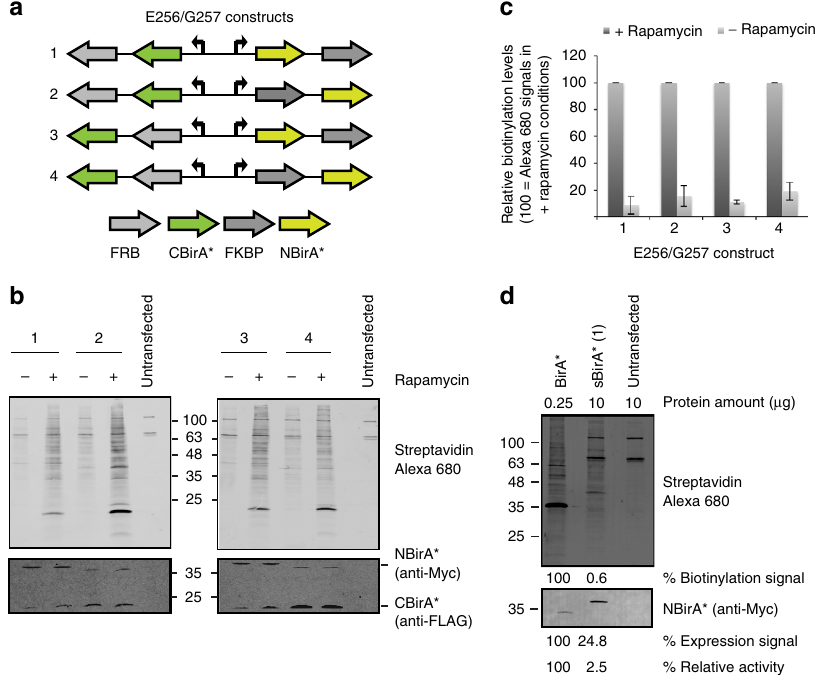
Figure 2 | Characterization of split-BioID. ( a ) The four tested constructs, corresponding to all possible orientations of the CBirA*-FRB and NBirA*-FKBP fusions. ( b ) Blots of lysates of HeLa cells transiently transfected with the constructs shown in a , and treated with or without rapamycin. Biotinylation was analysed using Alexa680-labelled streptavidin, and expression levels of the fusion proteins with antibodies against FLAG and Myc tags as indicated. ( c ) Quantification of b : relative overall biotinylation levels were estimated by integrating Alexa680 signals in each lane in b and normalizing them to the signal measured for an endogenous biotinylated protein in the same lane. Signals from non-transfected samples were set to 0% (error bars, s.d.; n ¼ 3 independent experiments). ( d ) Activity of the original BirA* compared to the split-BirA* (construct 1). Total biotinylation (streptavidin-Alexa680) and protein expression levels (anti-Myc signal) were set to 100% for BirA*, taking into account the different protein amounts loaded. Relative activity is the ratio of biotinylation over Myc